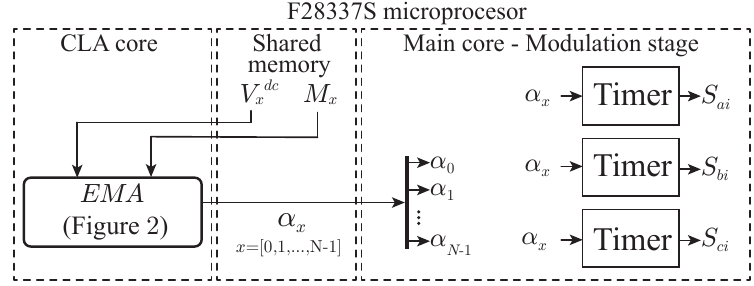
Figure 6. Physical implementation of the proposed EMA-based SHM. CLA,Control-Law Accelerator.